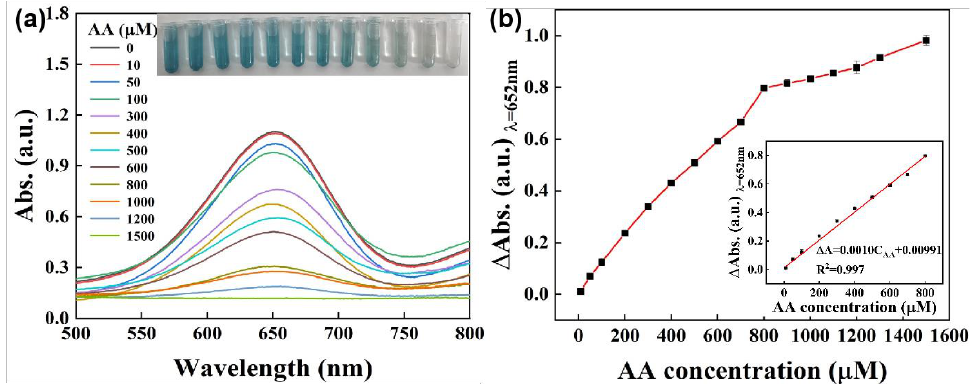
Figure 8. ( a ) The UV – vis absorption spectra of the reaction system of Ni 0.1 Cu 0.9 S + H 2 O 2 + TMB in the presence of AA with varied concentrations. (The inset displays the color changes of reaction solution with the increasing AA concentration). ( b ) Plots of the absorbance difference (∆A) at 652 nm versus the AA concentration. Inset is the linear calibration plot corresponding to absorbance against the concentration of AA. The error bars represent the standard deviation values of three measurements.